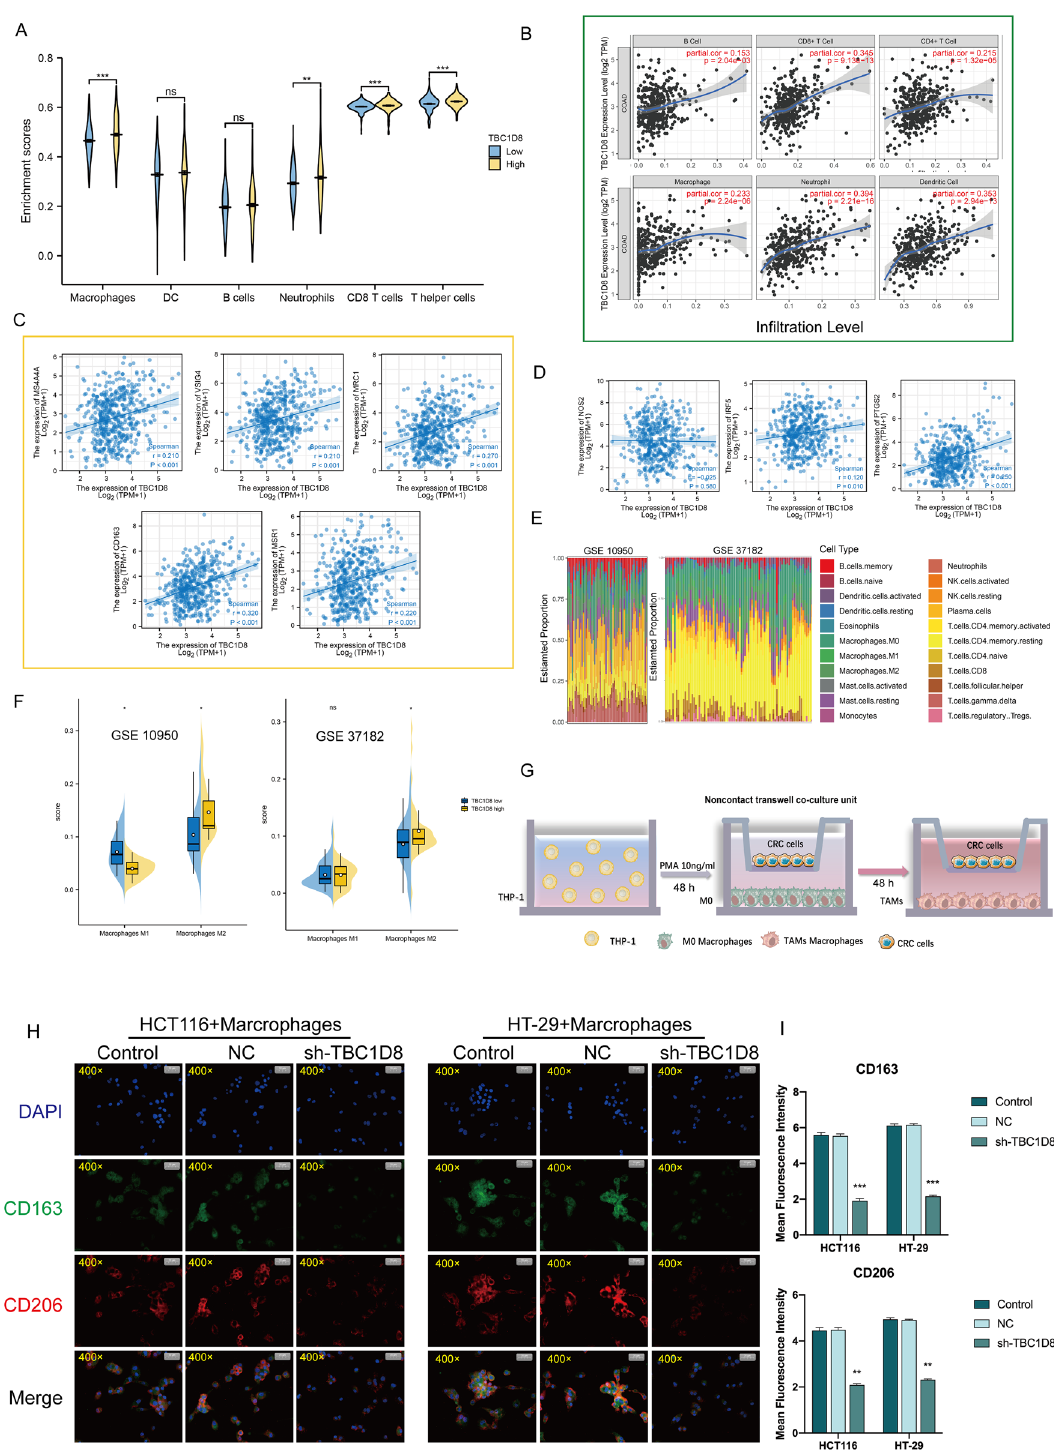
Figure 7. Immune analysis of TBC1D8 . ( A ) Effects of high and low T BC1D8 expression on immune cells. ( B ) Relationship between TBC1D8 level and degree of immune infiltration, from TIMER. ( C , D ) Relationship between TBC1D8 and levels of ( C ) M2 macrophage markers and ( D ) M1 macrophage markers. ( E ) Tumor-initiating cell proportions in CRC samples. from GSE10950 and GSE37182 data based on CIBERSORT. ( F ) Relationship between TBC1D8 level and macrophage abundance based on CIBERSORT, from GSE10950 and GSE37182 data. ( G ) Diagram of co-culture system. ( H ) Double-immunofluorescence staining of M2 macrophage markers CD206 (red) and CD163 (green); nuclei are stained with DAPI (blue) (Magnification, × 400, scale bars = 20 μm) (n = 3 replicates). ( I ) Intensity of immunofluorescence (mean ± SEM) (n = 3 replicates). Data are means ± SEM *p < 0.05; **p < 0.01; ***p <